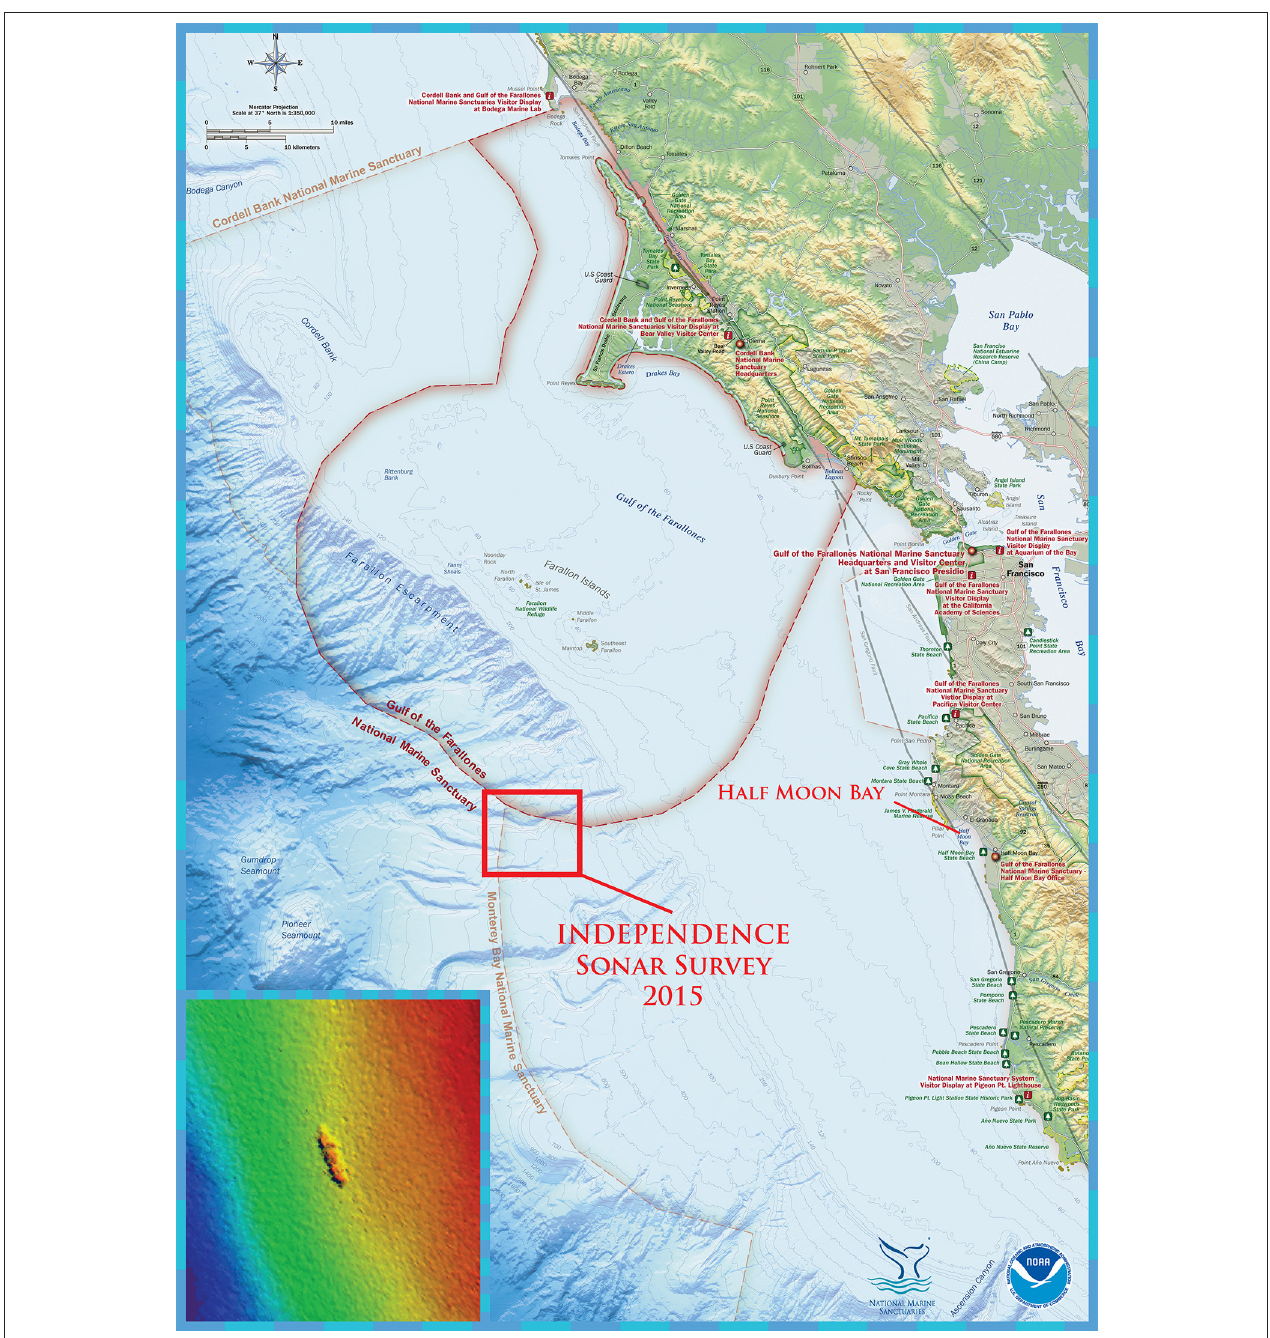
FIGURE 7 | Location of the wreck and survey area off the central California coast of the United States (NOAA/Robert